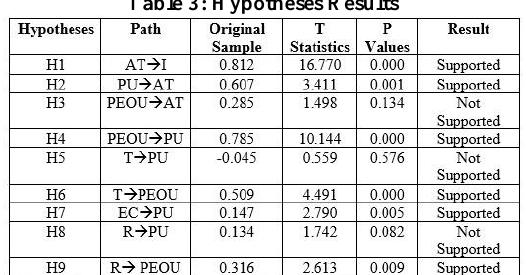
Table 5: Results of R² and R²